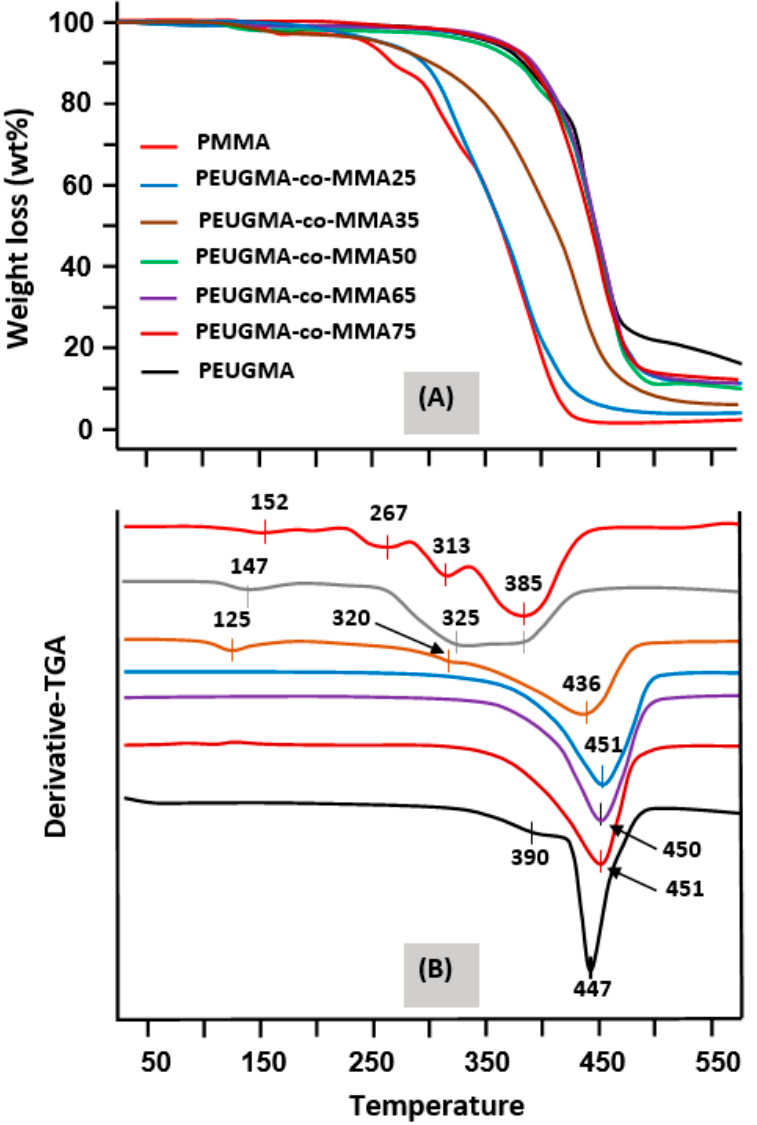
Figure 15. TGA ( A ) and derivative-TGA ( B ) thermograms of pure PMMA, pure PEUGMA and PEUGMA-co-MMA with different EUGMA content.